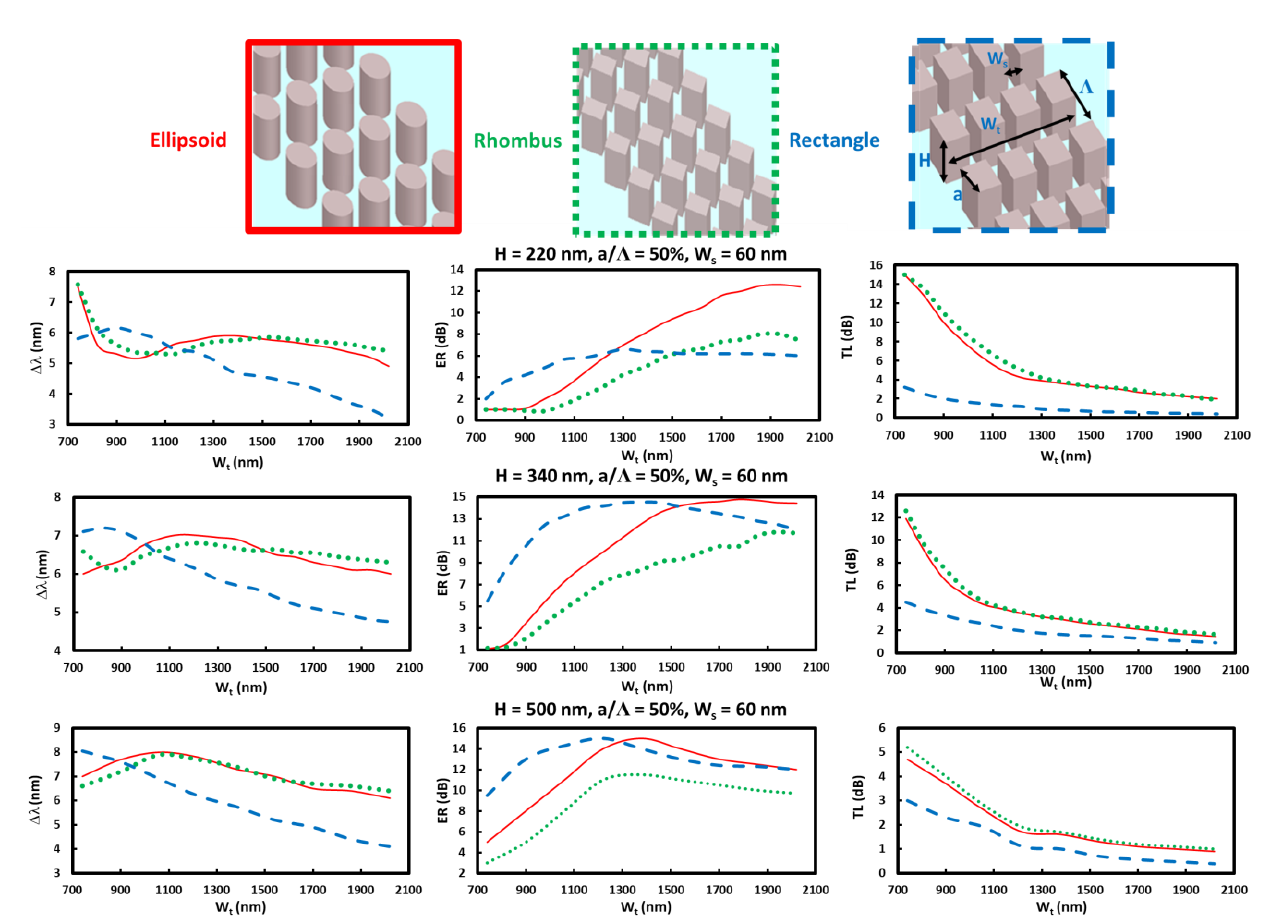
Figure 5. Sensing characteristics of MS-SW BG RI sensors for three pillar configurations schematically shown in the top ∆ λ ; ER and TL dependent on W t at height of H = 220 nm, 340 nm, and H = 500 nm with a/ Λ = 0.5 and W s = 60 nm, where Λ is fitted to have sensing peak at 1550 nm.